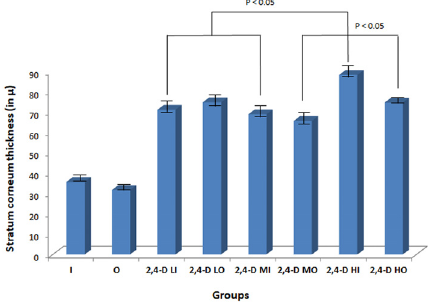
Figure 4. Thickness of the esophagus epithelium (in m ) in the experimental groups (n=79). Data are reported as means ± SD (ANOVA). I: Inhalation control group; O: Oral control group; 2,4-D LI: Group exposed to low concentration of 2,4-dichlorophenoxy- acetic acid (2,4-D) by inhalation; 2,4-D LO: Group exposed to low concentration of 2,4-D orally; 2,4-D MI: Group exposed to moderate concentration of 2,4-D by inhalation; 2,4-D MO: Group exposed to moderate concentration of 2,4-D orally; 2,4-D HI: Group exposed to high concentration of 2,4-D by inhalation; 2,4-D HO: Group exposed to a high concentration of 2,4-D